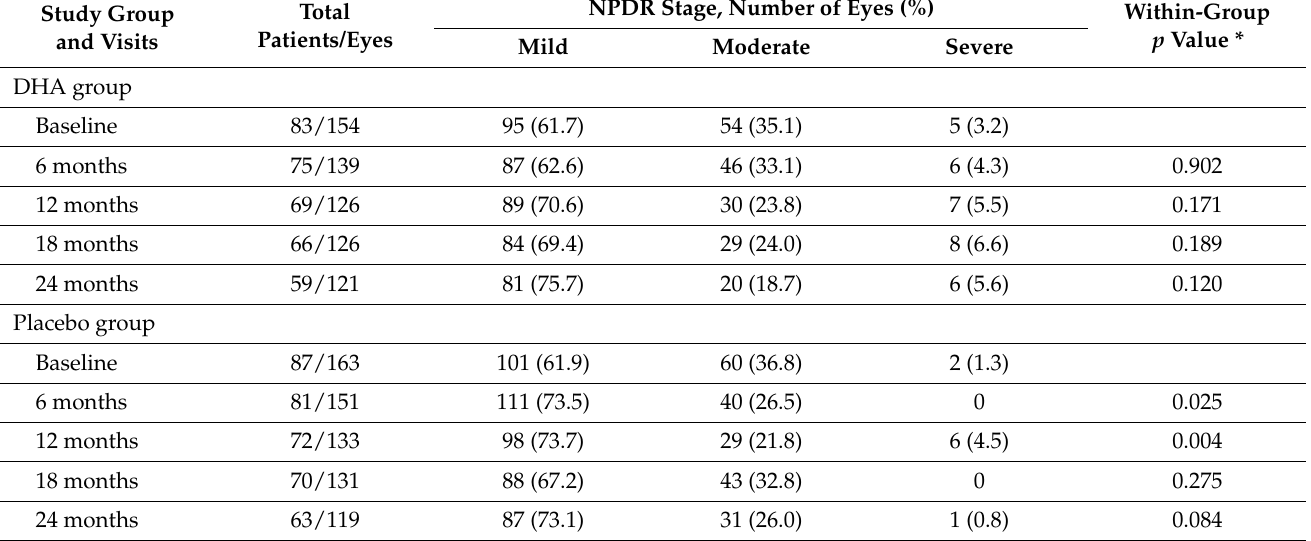
Table 4. Changes of NPDR stage in the two study